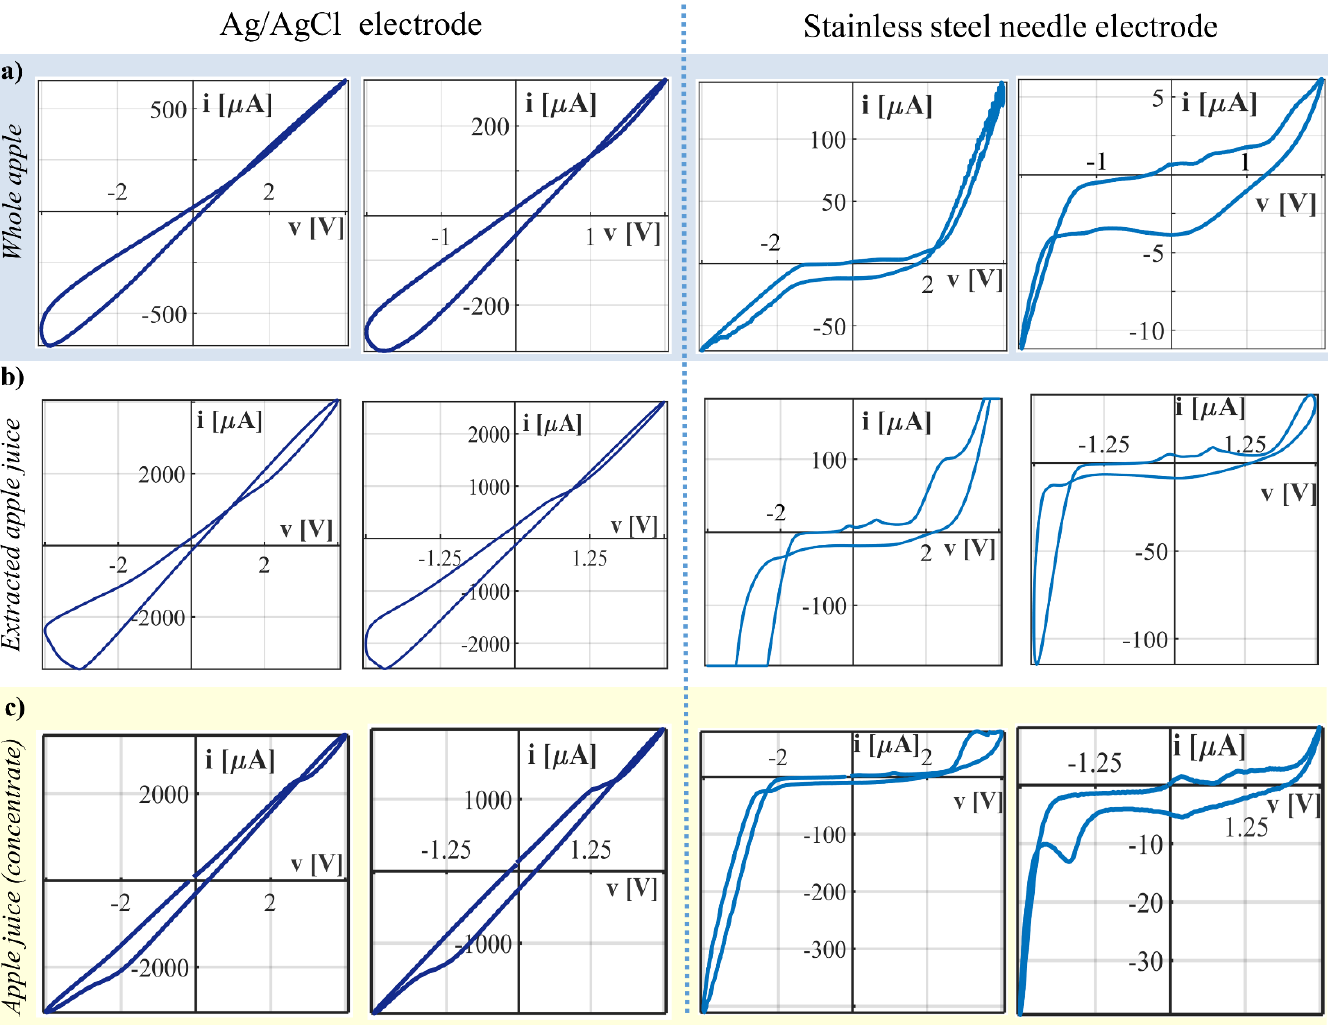
Fig. 3: Voltage current plots recorded from the apples, always shown for the second period of each measurement. The dark blue plots represent the results from recordings with the silver/silver chloride electrode and the light blue plots from the recordings with the stainless steel needle electrode. All shown results were obtained by applying sinusoidal voltages with a frequency of 0.005 Hz and different amplitudes. a ) Results from the measurements on one whole apple (A) (used amplitudes were 4 V and 2 V). Similar results were obtained from two other apples (B and C). The recordings from the apple D (see Fig. S2) were slightly more linear. b ) Recordings from the apple juice that was manually extracted (used amplitudes were 4 V and 2.5 V). The cutoff in the plot of the recording with the stainless steel needle at 4 V amplitude is due to saturation of the transimpedance amplifier. c ) Recordings from the apple juice from concentrate (used amplitudes were 4 V and 2.5